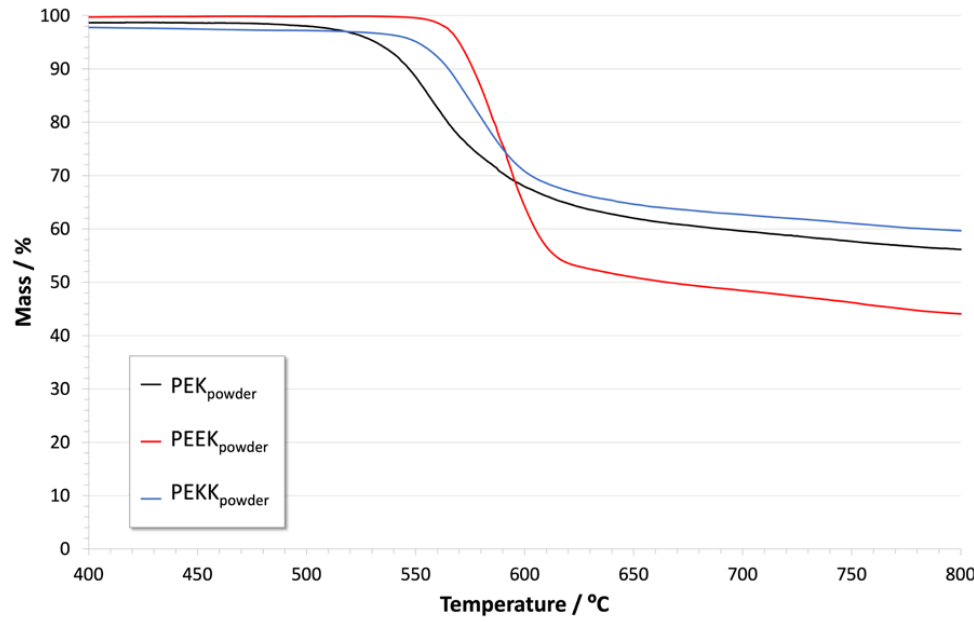
Figure 5. Thermogravimetric analysis of PEK, PEEK and PEKK powders in nitrogen.